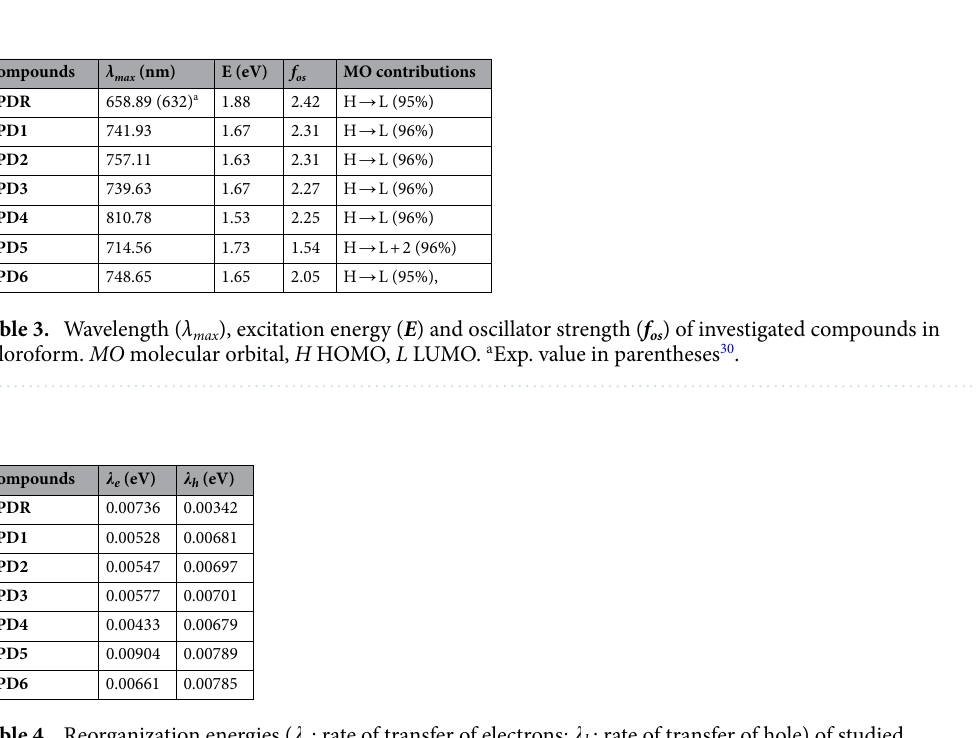
Table 4. Reorganization energies ( (cid:31) e ; rate of transfer of electrons ; (cid:31) h : rate of transfer of hole) of studied